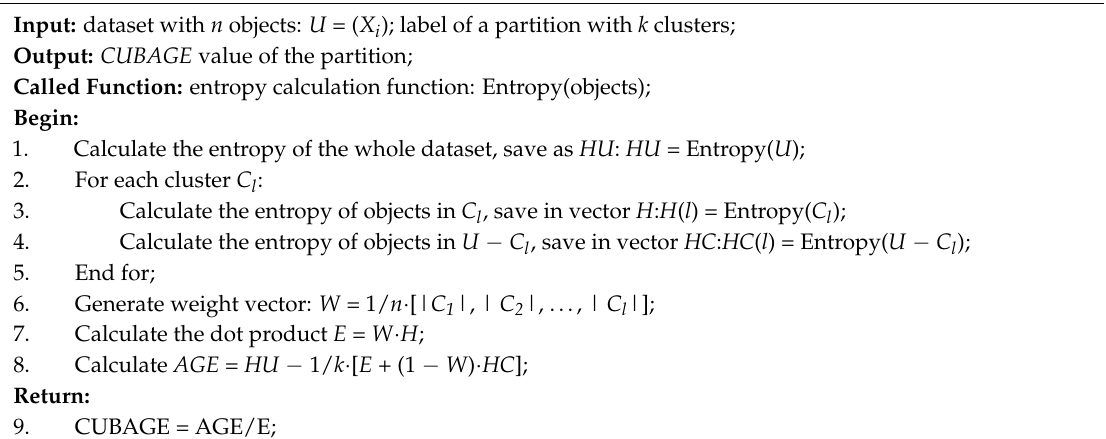
Algorithm 1 Clustering Utility based on Entropy ( CUBAGE )